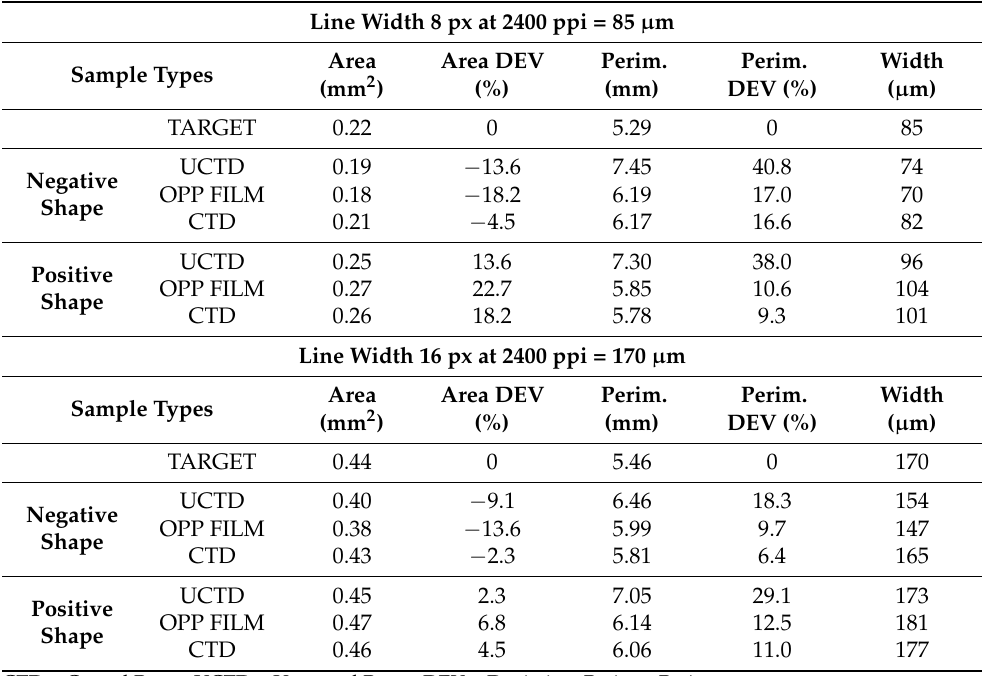
CTD = Coated Paper, UCTD = Uncoated Paper, DEV = Deviation, Perim.=